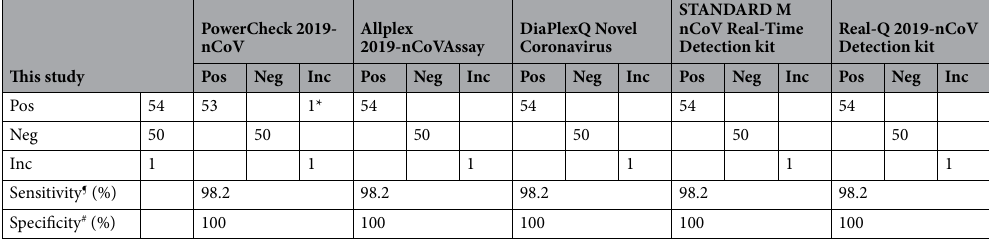
Table 6. Comparison of sensitivity and specificity of SARS-CoV 2 detection in respiratory samples using Emergency Use Authorization (EUA) PCR kits and the assay developed in this study. *Inconsistent (Inc) results in one kit were confirmed by further examination to be an inconclusive case and not a false case. ¶